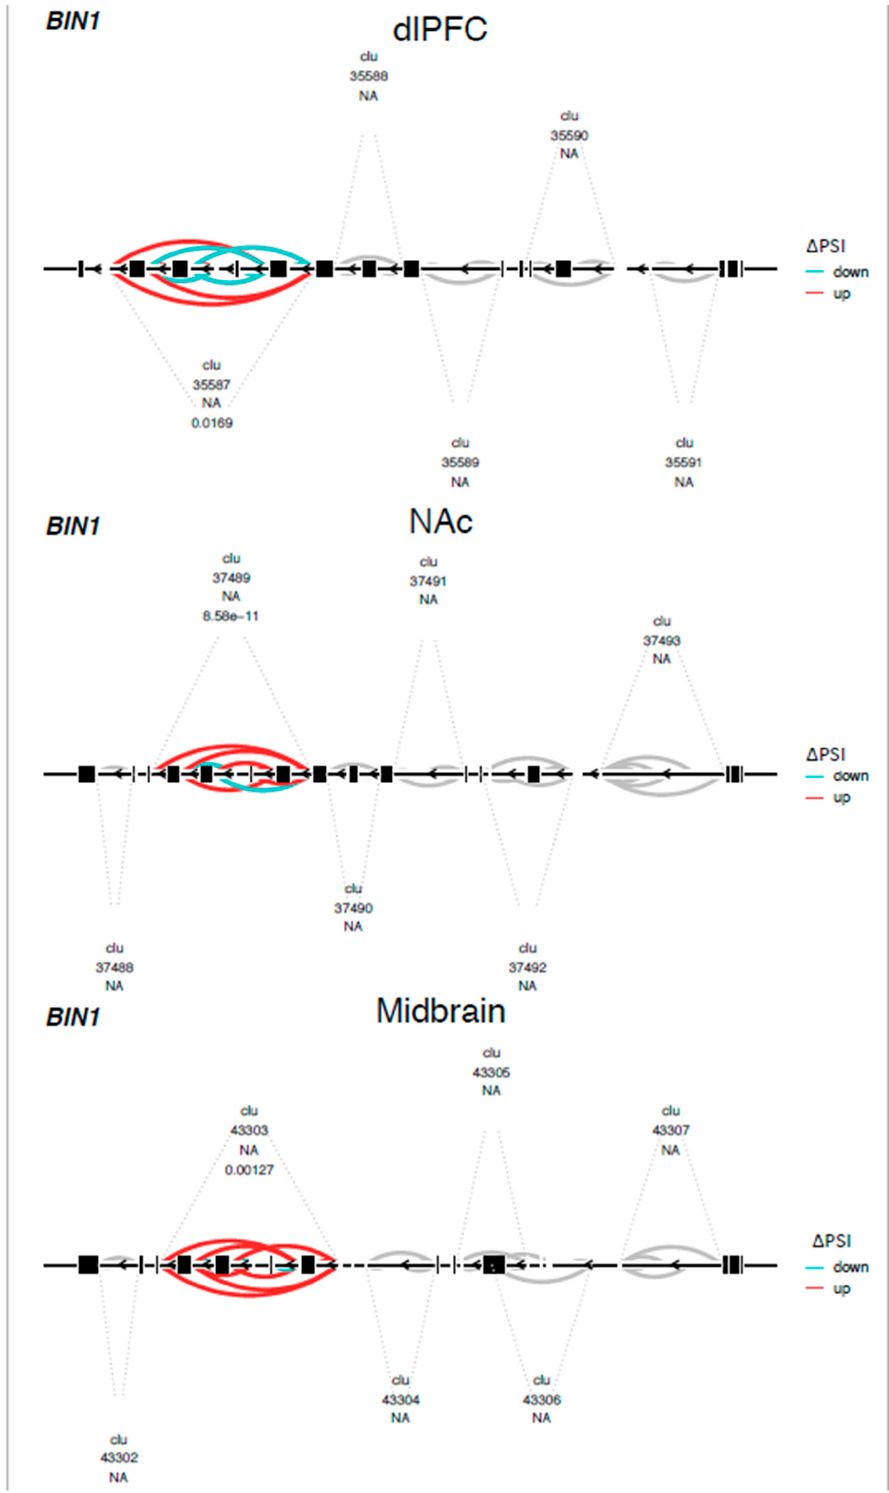
Figure 3. Differential splicing of the BIN1 gene in the CLAP domain across brain regions. Leafviz plot of BIN1 gene showing a complex splicing event associated with OUD across brain regions. Red indicates increased and blue represents decreased intron usage in individuals with OUD relative to the controls. For a list of specific differential splicing events and their functional characterizations, see Supplementary File S1. Clu = cluster. The number directly below it is an arbitrary cluster number. The number below NA is the FDR-adjusted p -value for a cluster.